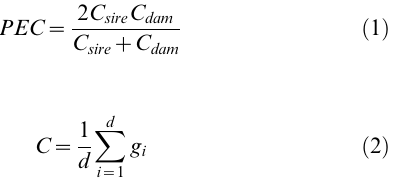
Table S1 Results of relationship inference based on pairwise kinship coefficient ( W ) and probability of zero IBD-sharing ( p 0 ) as estimated by genomic or